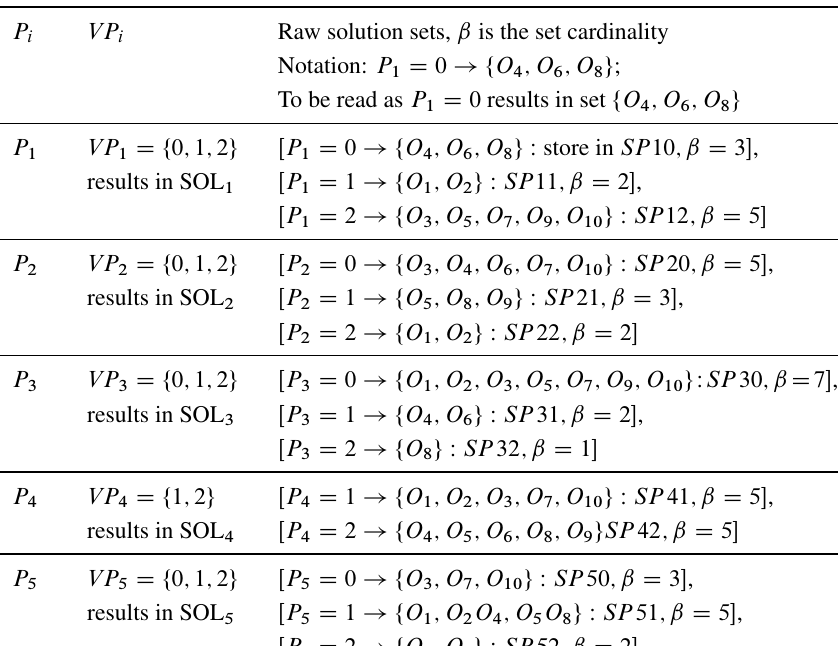
Table 2. Creation of raw solution sets for